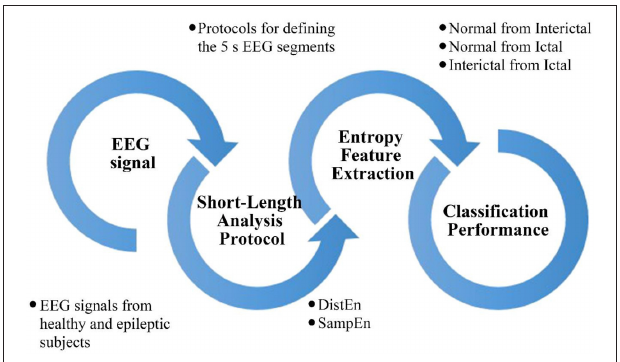
FIGURE 1 | Overall block diagram summarizing steps of this